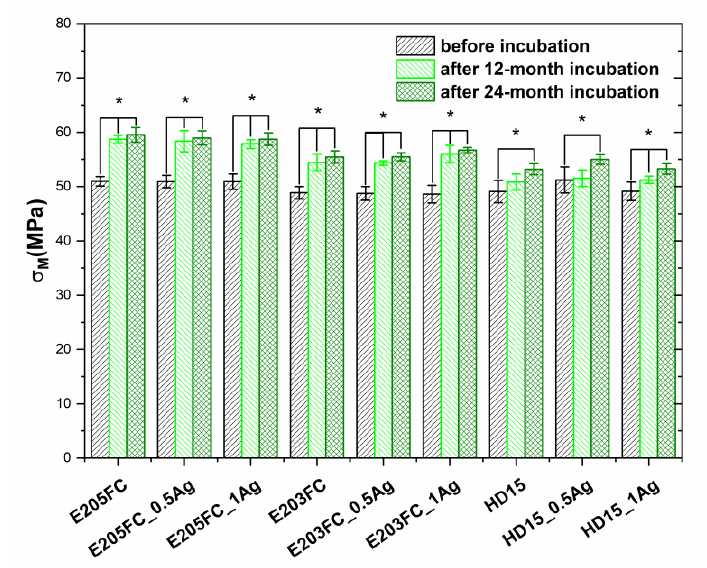
Figure 6. Tensile strength ( σ M ) of pure polymers and polymers containing 0.5 wt % and 1.0 wt % of silver nanoparticles AgNPs. Statistically significant differences ( p < 0.05) between materials before and after 12- and 24-month incubation are indicated by asterisk (*).